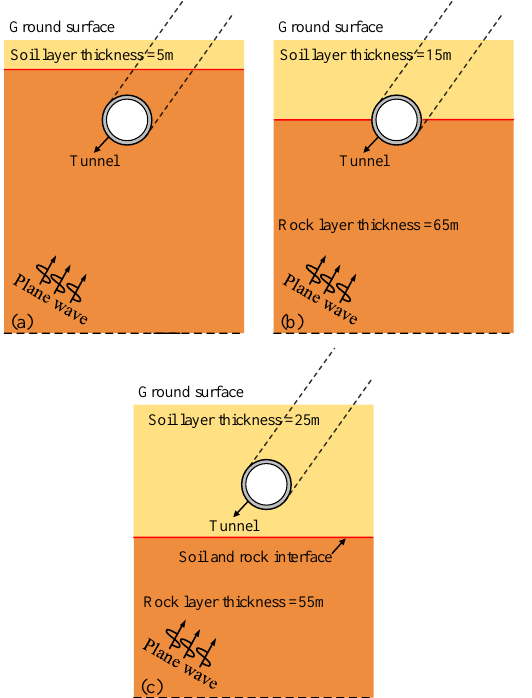
Figure 14. The location of soil−–rock interfaces: ( a ) soil layer thickness 5 m, ( b ) soil layer thickness 15 m and ( c ) soil layer thickness 25 m.